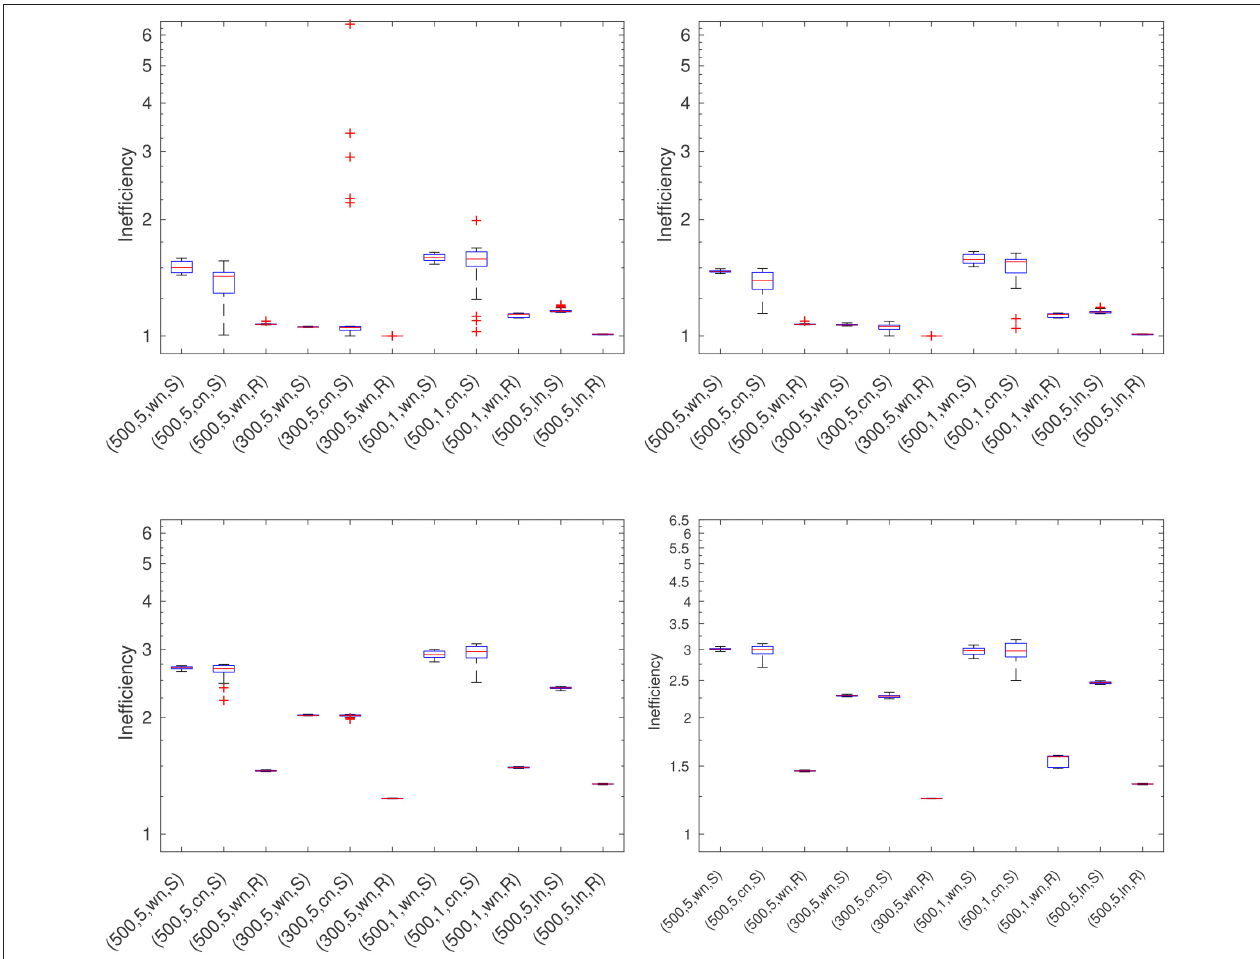
FIGURE 4 | DP for the RFMP (Left-hand top) and the ROFMP (Right-hand top) and TDP for the RFMP (Left-hand bottom) and the ROFMP (Right-hand bottom) . datum, that means we get our noisy data